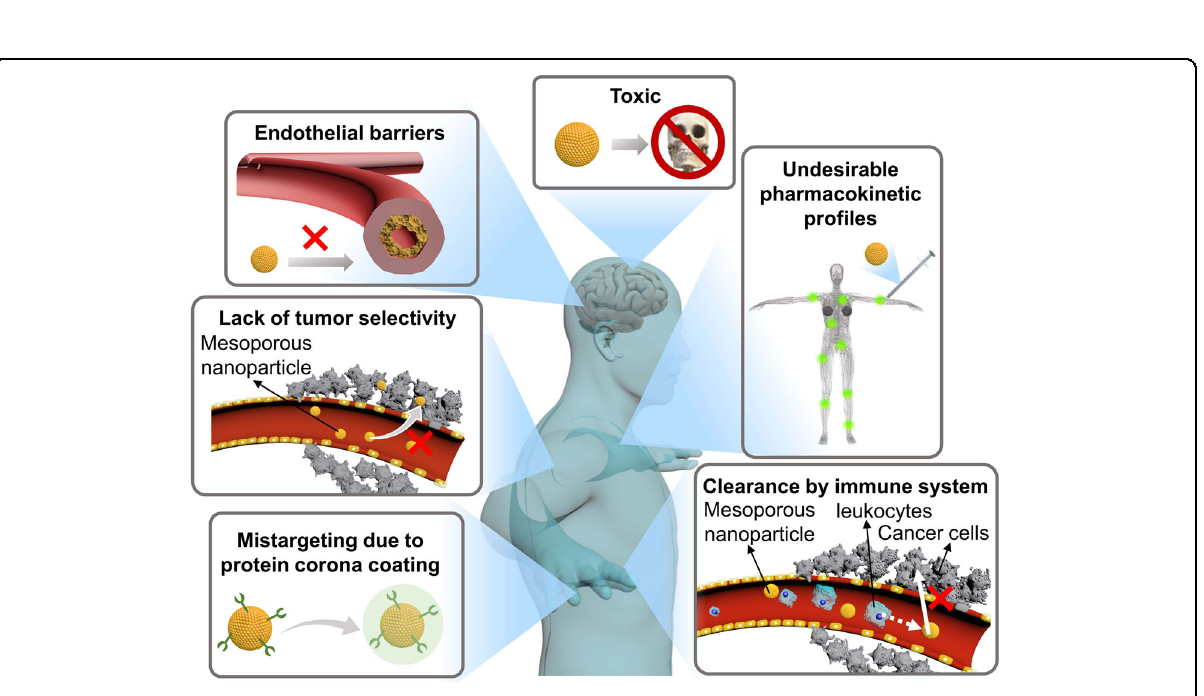
Fig. 17 Biological barriers of injectable mesoporous nanoparticles in practical applications. The main biological barriers are endothelial bariers, toxicity, undesirable pharmakokinetic pro fl es, rapid clearance by immune system, mistargeting due to protein corona coating, and lack of tumor selectivity.